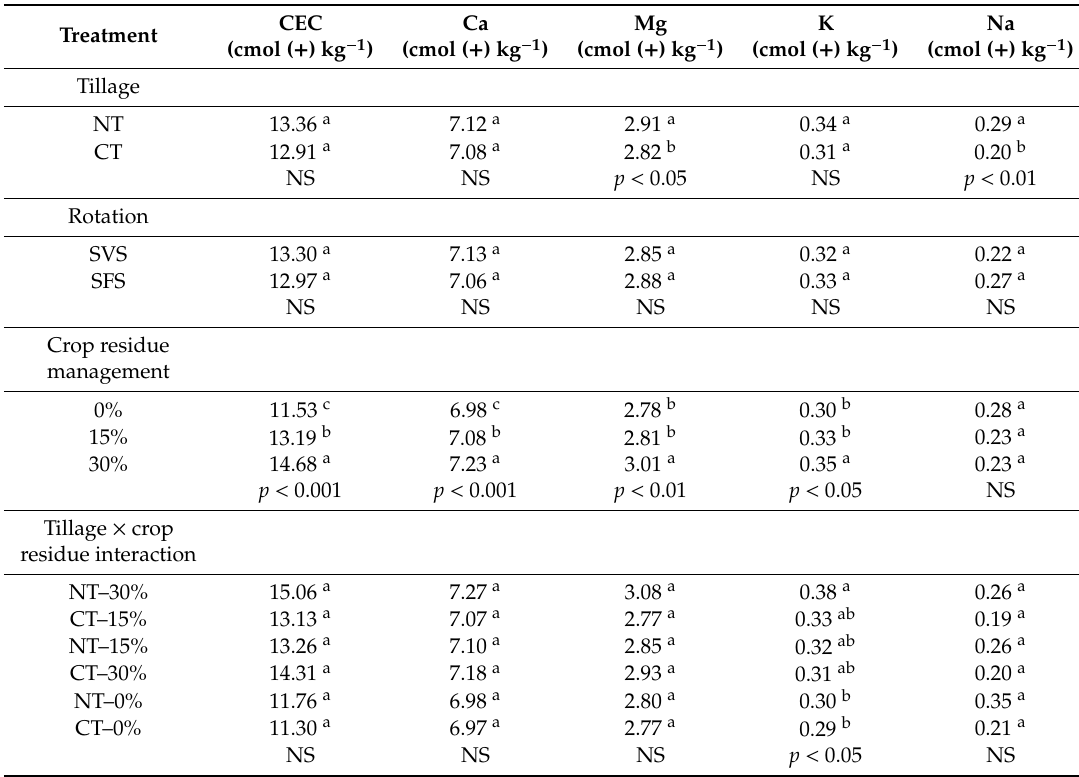
Table 4. Mean separation results of cation exchange capacity (CEC), calcium (Ca), magnesium (Mg), potassium (K) and sodium (Na) as influenced by tillage, rotation, crop residue management and the tillage × crop residue